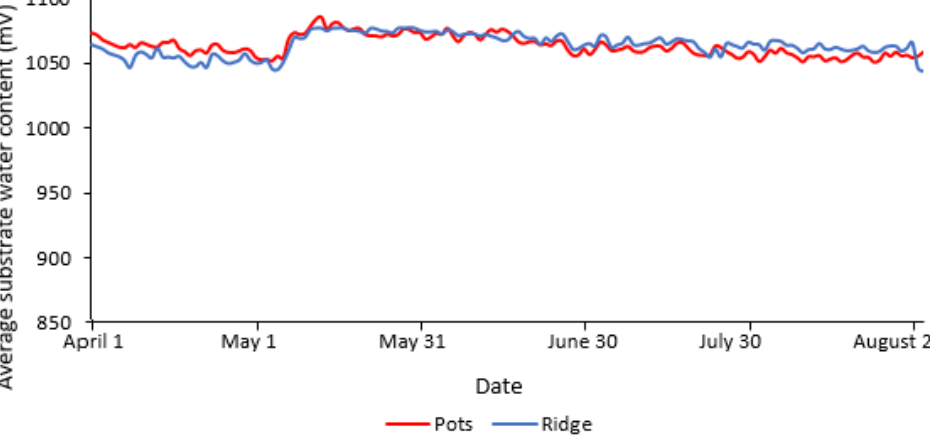
Figure 2. Maximum air temperatures and substrate temperatures for the pots and ridge (as indi ‐ cated) from 1 April 2020 to 31 August 2020. 3.2. Plant Growth and Yield ‘Duke’ and ‘Aurora’ plants grown in pots showed significantly lower growth than those grown along the ridge (Figure 3). For ‘Brigitta’, no significant differences were seen. ‘Duke’ showed the highest growth for both pots and the ridge, with ‘Aurora’ and ‘Brigitta’ was similarly low for pots, and ‘Brigitta’ the lowest for the ridge.